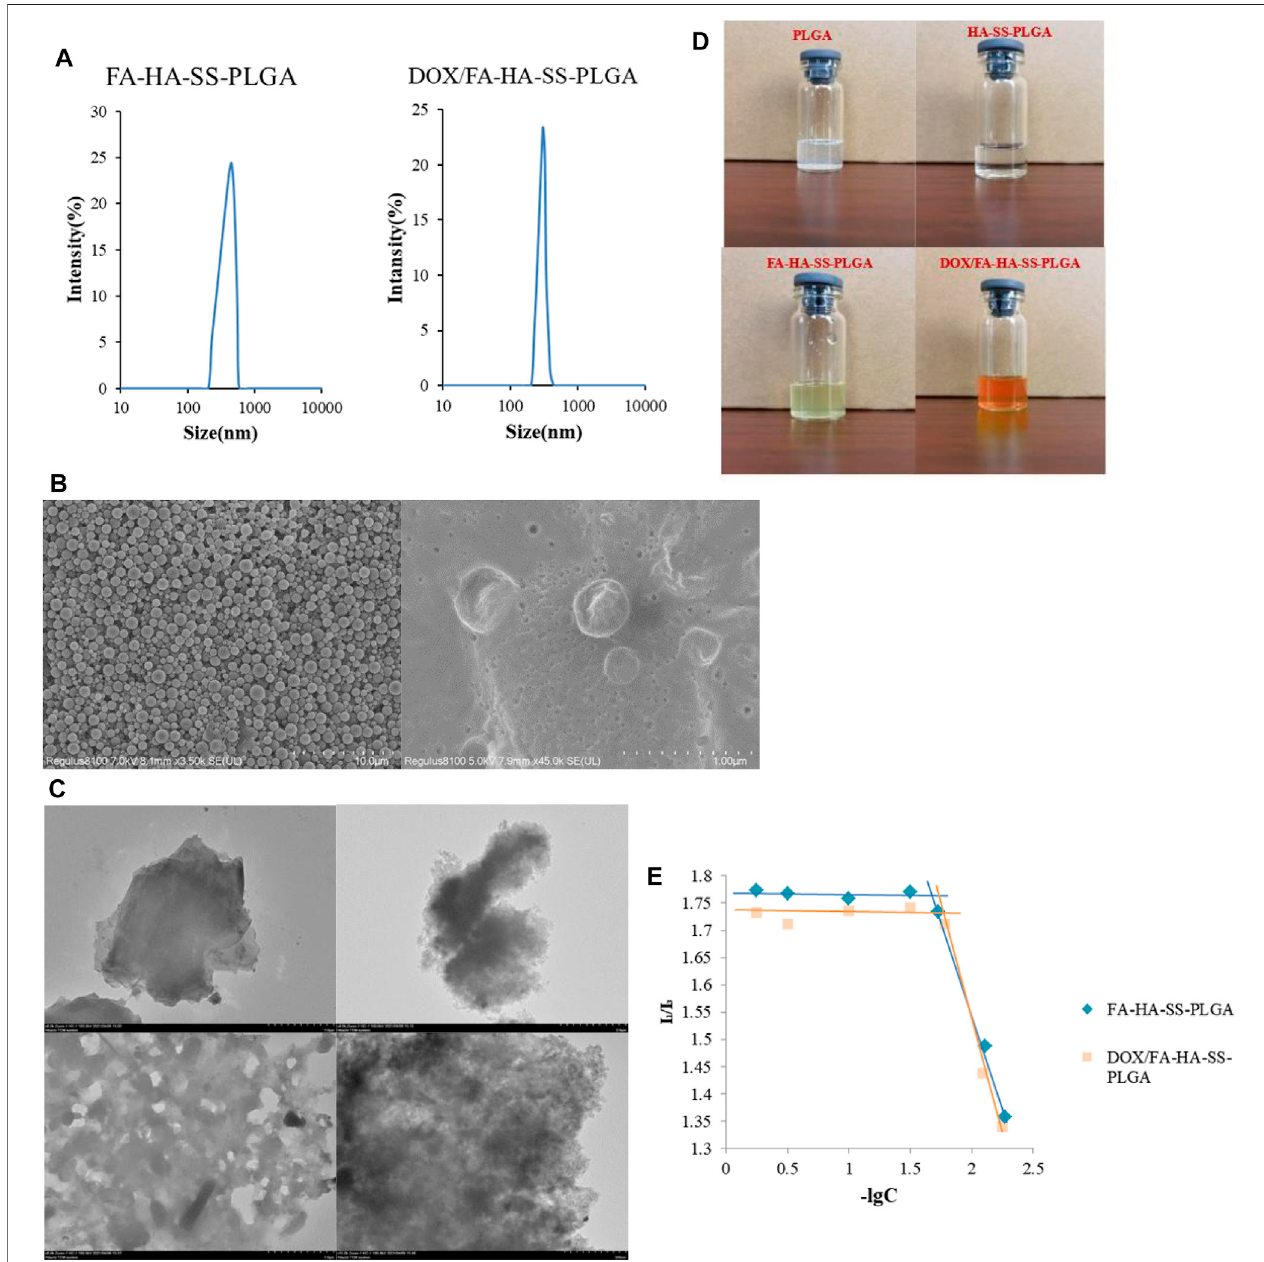
FIGURE 5 | Properties of the prepared polymers and micelles. (A) Size distribution of FA-HA-SS-PLGA and DOX/FA-HA-SS-PLGA. (B) Scanning electron microscopy(SEM)micrographsofFA-HA-SS-PLGAandDOX/FA-HA-SS-PLGA. (C) Transmissionelectronmicroscopy(TEM)micrographsofPLGA,HA-SS-PLGA,FA- HA-SS-PLGA, and DOX/FA-HA-SS-PLGA. (D) Dispersion of various polymers in water after 72 h. (E) Critical micelle concentrations of FA-HA-SS-PLGA and DOX/FA- HA-SS-PLGA. The data were expressed as mean ± SEM ( n = 3).